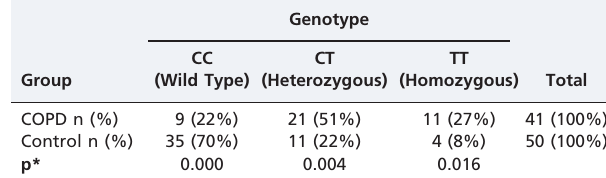
Table 2 - Allelic frequency of the MDR-1 gene (P-glycoprotein, ATP-binding cassette ABC superfamily of membrane transporters) C3435T polymorphism in patients with COPD and healthy control